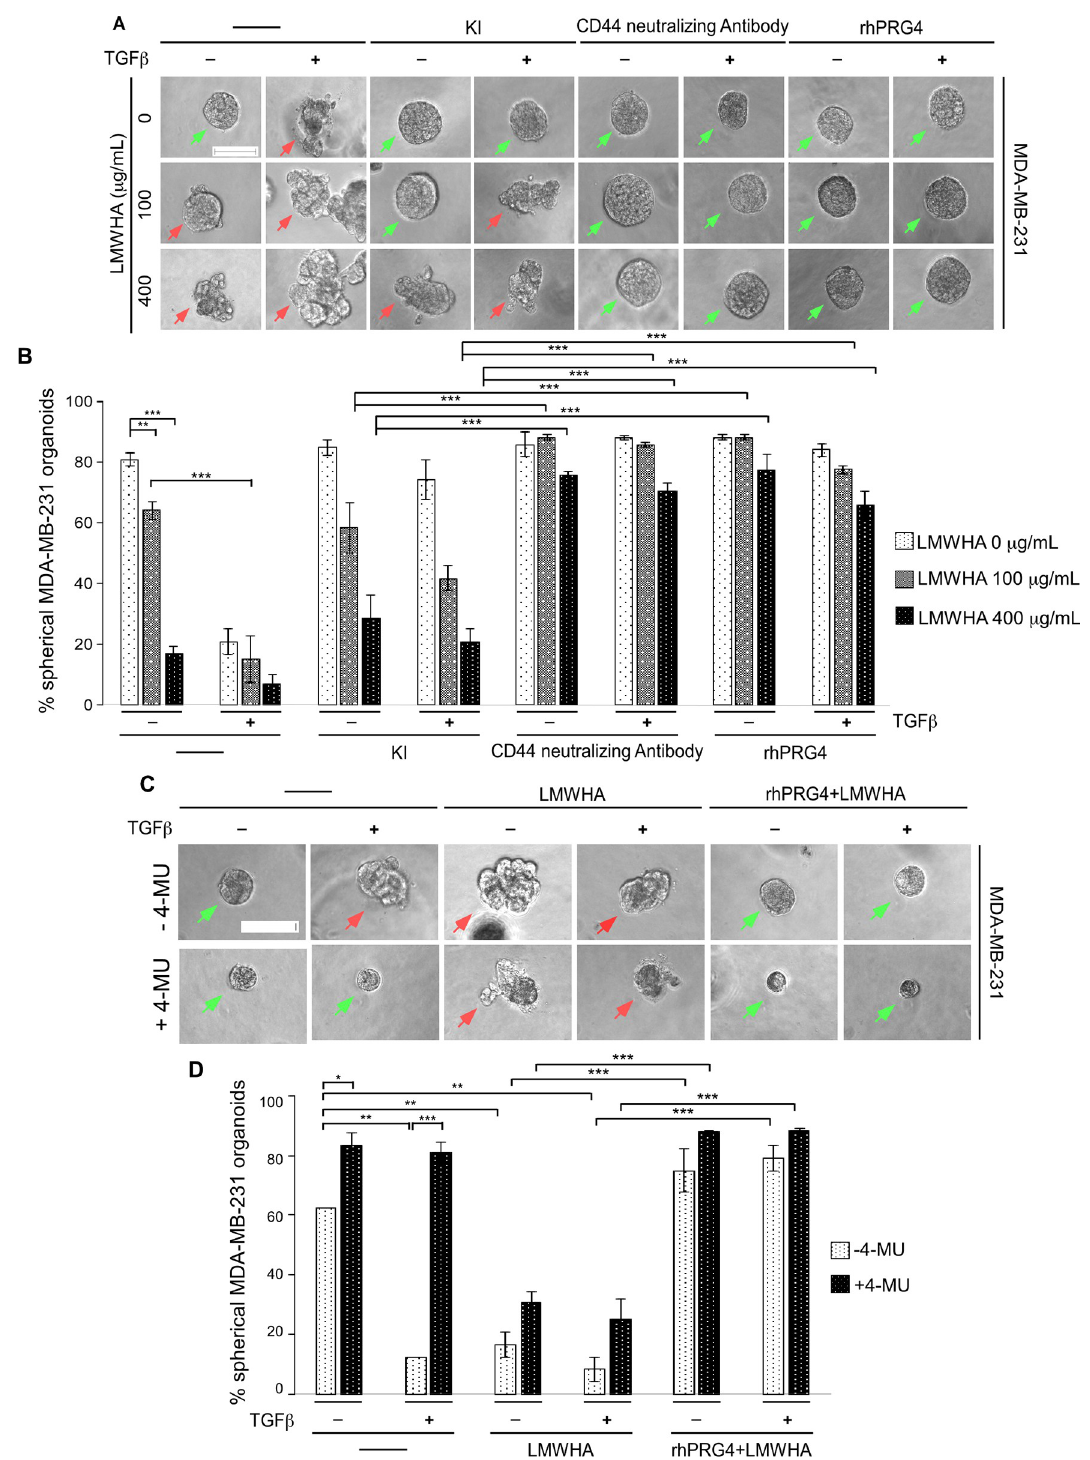
Fig 7. TGF β induces invasiveness in the breast cancer cells in a HA-CD44-dependent manner. (A) Representative DIC light microscopy images of 8-day old three-dimensional MDA-MB-231 cell-derived organoids that were left untreated (-) or incubated with different concentrations of LMWHA (100 or 400 μ g/mL), without or with 100 pM TGF β , along with or without KI (10 μ M), CD44 neutralizing antibody (2.5 μ g/mL), or rhPRG4 (100 μ g/mL), in complete growth medium. (B) Bar graph depicts mean ± SEM proportion of spherical organoids expressed as a percentage of total organoids counted for each experimental condition from three